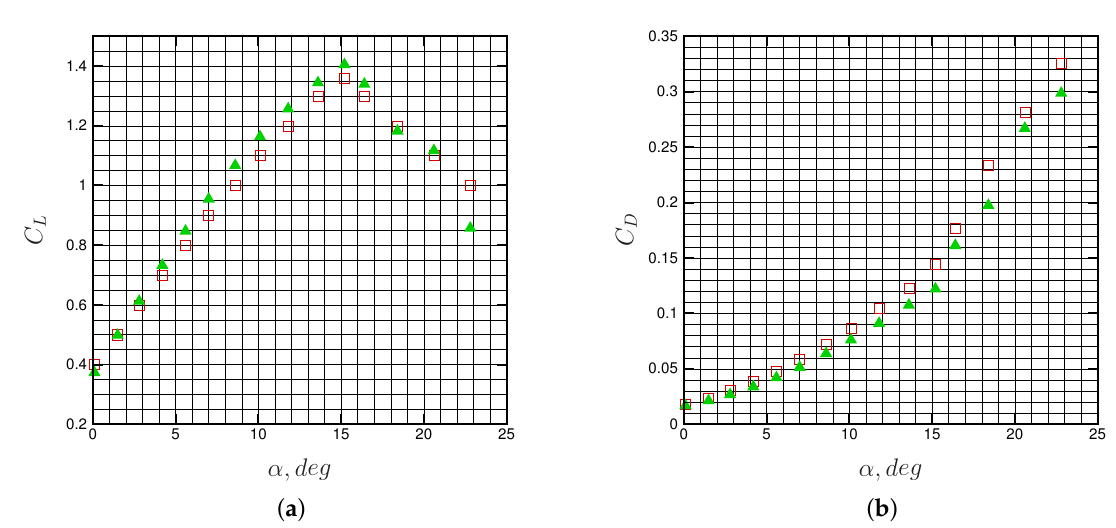
Figure A3. Comparison between CFD and experimental results for the 3-D wing: ( a ) C L versus α , and ( b ) C D versus α ; [ ] present study, and [ ] ref.